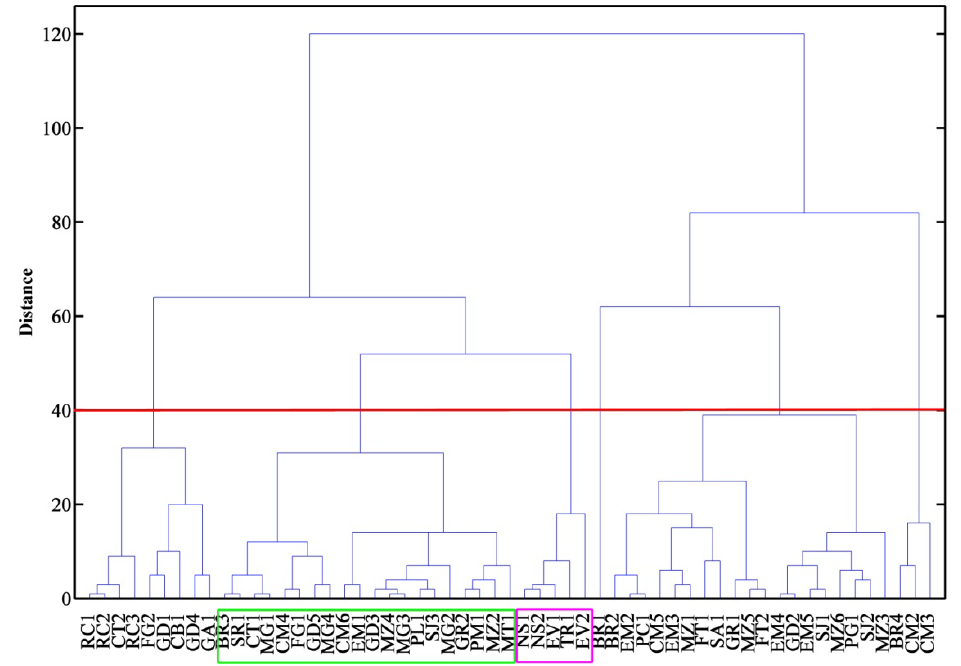
Figure 4. Dendrogram based on Chebyshev distance and complete linkage, applied to data obtained with sensor 3 and sensor